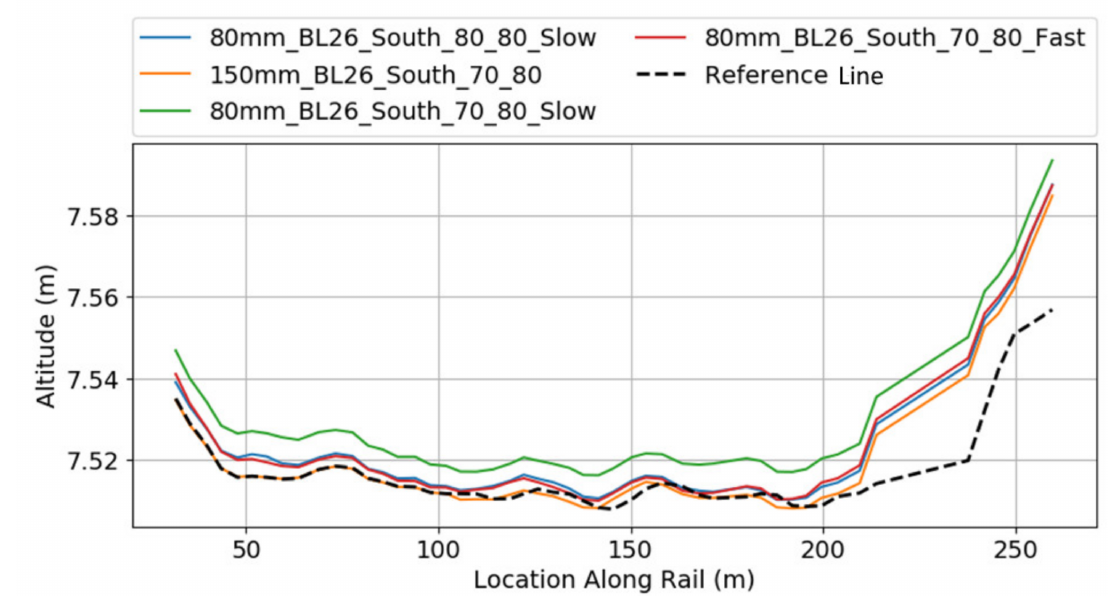
Figure 16. Deviation from the reference height along the reference axis using different flight and camera setups, continuous lines: our results, dashed line: reference